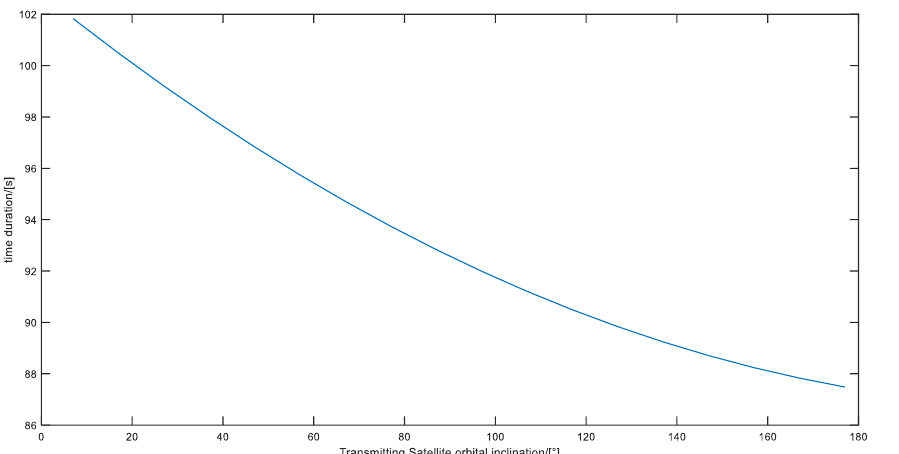
Figure 3. Variation in occultation duration with satellite inclination.